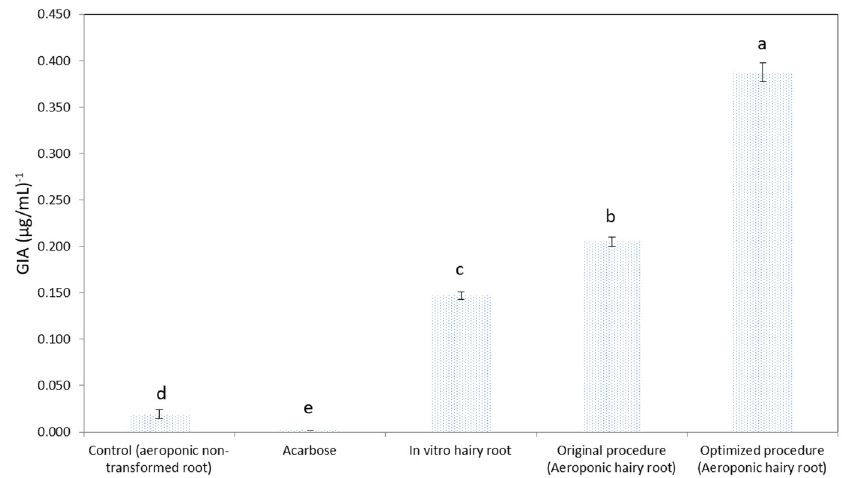
Figure 3. Evaluation of Urena lobata AHRs α -glucosidase inhibitory activity (GIA). Error bars represent standard deviations. The values in a line marked with different lower cases letters denote significant differences between samples at p < 0.05 (Duncan’s multiple range test).